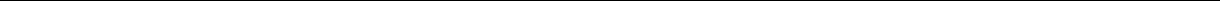
Figure 8 | Lineage tracing of Axin2 þ cells in taste papillae and sweat ducts and nails. ( a – j ) Adult Axin2-Cre ERT2/tdT R26R EYFP mice were tamoxifen treated at P60 and P61 and EYFP expression analysed in fungiform ( a , b , e , f ) and circumvallate ( c , d , g – j ) papillae after 40h, 6 months or 9 months as indicated. KRT14 marks basal cells ( a – d ); SOX2 marks basal and Type I TB cells ( b , d ); PLC b 2 marks Type II TB cells ( e – h ); SNAP-25 marks Type III TB cells ( i , j ). Yellow arrows indicate EYFP þ basal cells; red arrows indicate EYFP þ differentiated TB cells. Both basal and differentiated TB cells remain labelled over 6–9 months. ( k – n ) Adult Axin2-Cre ERT2/tdT R26R mTmG mice were treated with tamoxifen on 2 successive days and mGFP expression analysed in cryosectioned circumvallate papillae at 40h ( k , m ) and 4.5 months ( l , n ) as indicated. KRT14 marks basal cells ( k , l ); ENTP2 marks differentiated Type I TB cells ( m , n ). Both basal KRT14 þ cells (yellow arrows) and differentiated KRT14 (cid:2) cells, including ENTP2 þ Type I cells, (red arrows) were labelled at 40h and maintained label after 4.5 months. ( o – r ) Sectioned sweat ducts ( o , p ) and nail ( q , r ) from Axin CreERT2/tdT R26R mTmG mice tamoxifen treated at P20-21 and analysed at the stages indicated. Yellow arrows indicate KRT14 þ basal cells; red arrows indicate KRT6 þ sweat duct suprabasal cells ( o , p ) or KRT14 (cid:2) differentiating nail plate cells ( q , r ). Insets in q are magnified images of boxed region; lower image in r is a higher magnification photomicrograph of the arrowed region in the upper image. At least three mice were analysed for each tracing condition; Z 10 labelled taste papillae or sweat gland ducts and